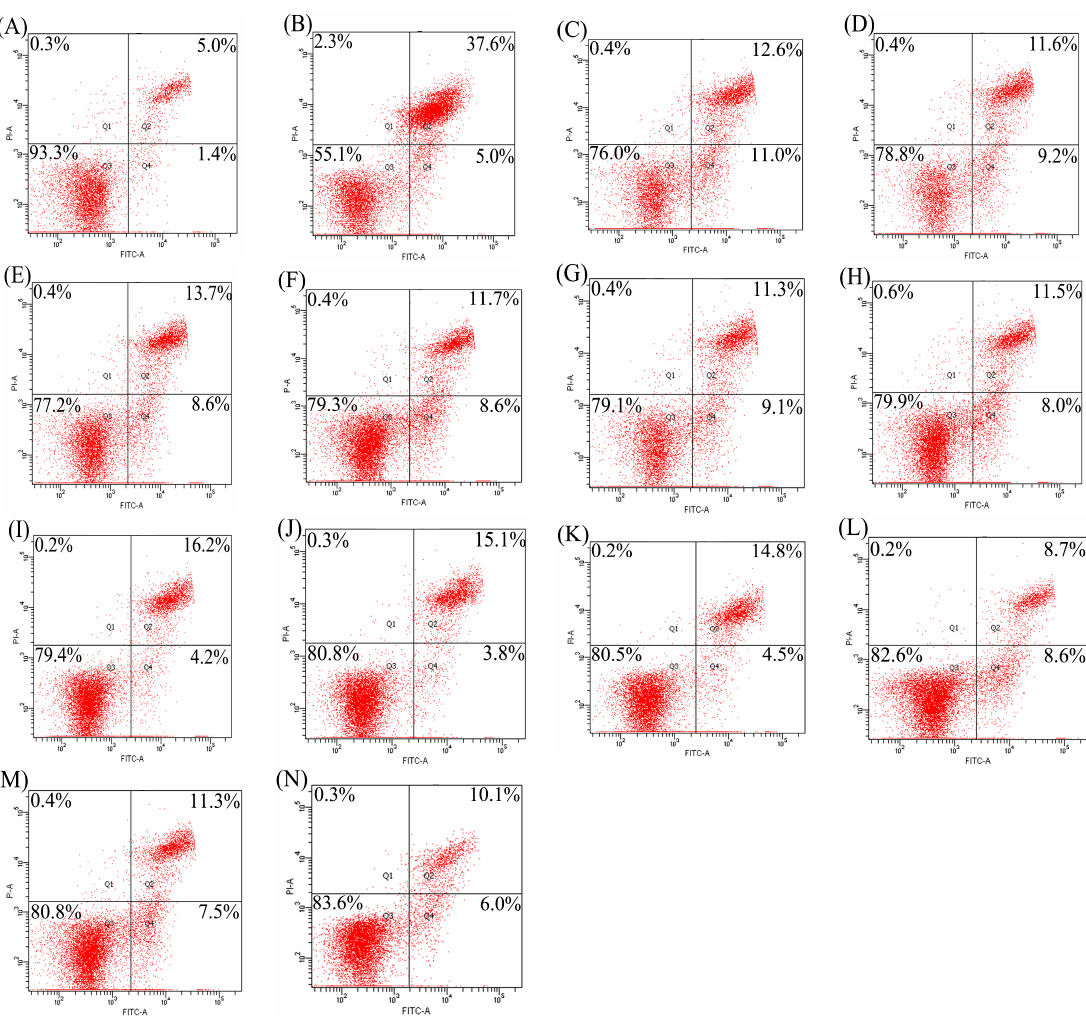
Figure 2. Detection of apoptotic prevention in the osteoblasts by flow cytomety. ( A ) control cells; ( B ) EP-treated cells; ( C – H ) the cells firstly treated by respective PAH1, PAH3, PNH1, PNH3, PPH1, and PPH3 for 48 h, and then treated by EP for 24 h; ( I – N ) the cells firstly treated by respective TAH1, TAH3, TNH1, TNH3, TPH1, and TPH3 for 48 h, and then treated by EP for 24 h.